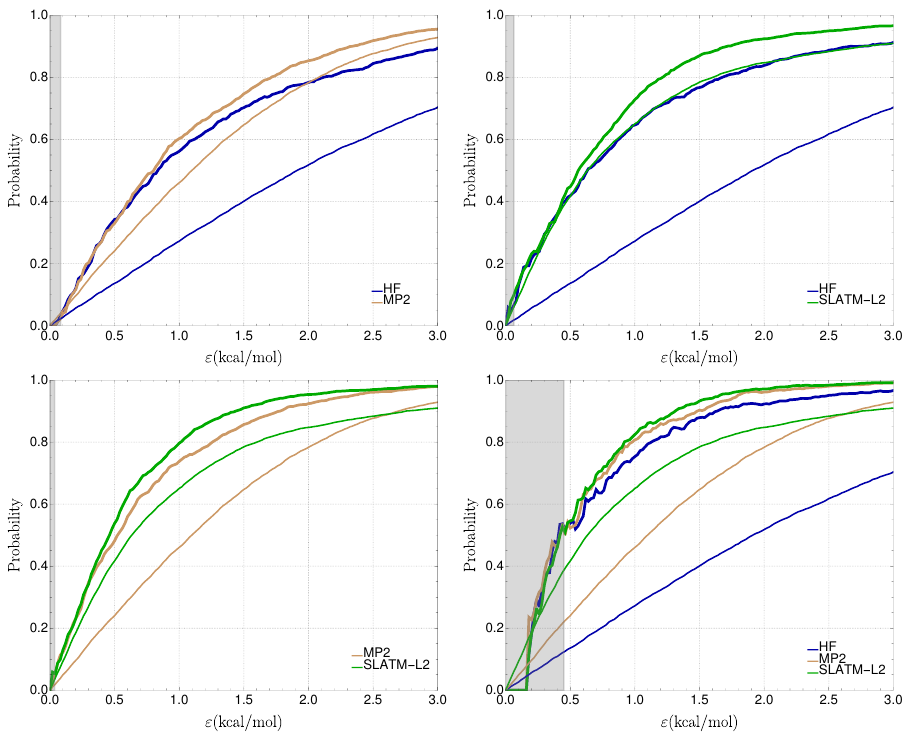
Figure 10. P r ( M , (cid:101) ) (thin curves) and P r | s ( M , (cid:101) ) (thick curves) for the pairs and triple in the set (HF, MP2, and